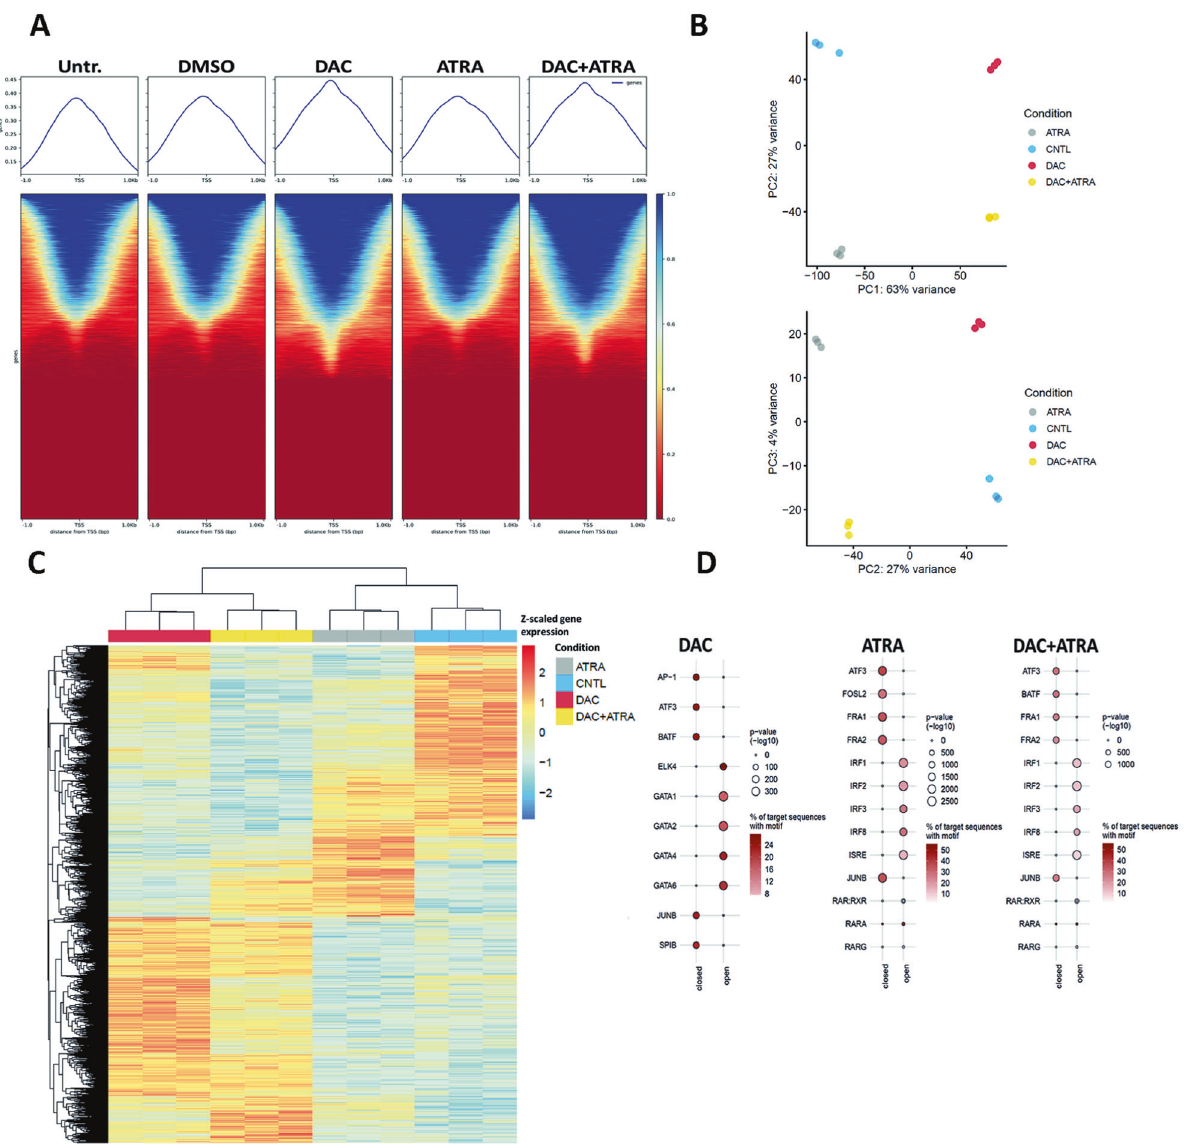
Fig. 3 Cooperation between DAC and ATRA in modulating chromatin accessibility. A Enrichment of accessible chromatin sites across the whole genome determined by ATAC-sequencing in U937 cells (technical triplicates) either untreated (untr.) or treated with DMSO, DAC, ATRA or DAC + ATRA at 72 h. Sequencing was performed with 40 million reads per sample (paired-ends). Mean alignment was at about 99%, with 51 – 63% uniquely mapped sequences. B Principal component (PC) analysis (PCA) of the assay for transposase-accessible chromatin sequencing (ATAC-seq) data of control (untreated, CNTL; n = 3), ATRA ( n = 3), DAC ( n = 3), and DAC + ATRA-treated ( n = 3) samples. Chromatin accessibility of the 200,000 most variably accessible peaks was used for dimensionality reduction. C Heatmap of the 50,000 most variable differentially accessible regions (DARs) from the ATRA vs. untreated (CNTL), DAC vs. CNTL, and ATRA + DAC vs. CNTL comparison. Euclidean distance of the z-scaled chromatin accessibility of DARs in all samples was visualized. D Homer transcription factor motif enrichment of differentially accessible regions (adj. p -value < 0.05 and absolute log 2 fold-change >1), strati fi ed in open and closed DARs. The top fi ve most signi fi cantly enriched transcription factor motifs as well as all signi fi cantly enriched (adjusted p -value < 0.05) retinoic acid response (RAR) motifs are visualized. The union set of all peaks was used as a background for enrichment U937 was analyzed by In fi nium HumanMethylation450 BeadChip disclose DNA hypomethylation at these regions, analyzing Illumina Array [22] at 72 und 120 h (Fig. 6A). The massive demethylating array data [8]. Indeed, demethylation was observed for all four effect in gene bodies and promoters of the DNMT inhibitor DAC genes (Figs. 4 and 5, lower panels), co-localizing with regions of could be detected both for the single-agent treatment as well as increased chromatin accessibility. when combined with ATRA. Correlation-based clustering revealed a subclustering, in the DAC/DAC + ATRA arm, for time point of Global DNA demethylation by decitabine is not enhanced by harvest (72 and 120 h) with one outlier (DAC sample harvested at all- trans retinoic acid 72 h) in the 120 h group. Given evidence in the literature that ATRA may also act by Global DNA methylation can also be detected by the inhibiting DNA methyltransferase activity, we wished to pursue methylation status of transposable repetitive LINE elements. These this hypothesis using a methylome-wide approach. Methylation in